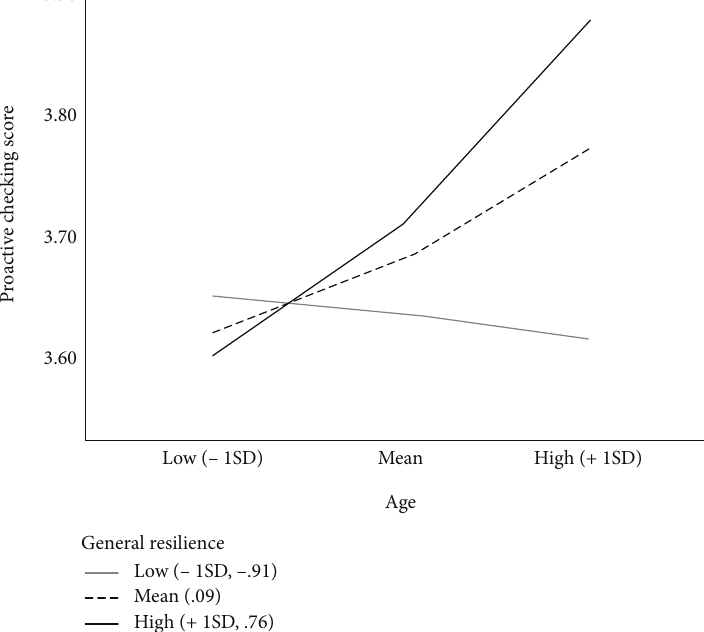
Figure 3: Moderation of the e ff ect of general resilience on proactive checking across low, mean, and high age